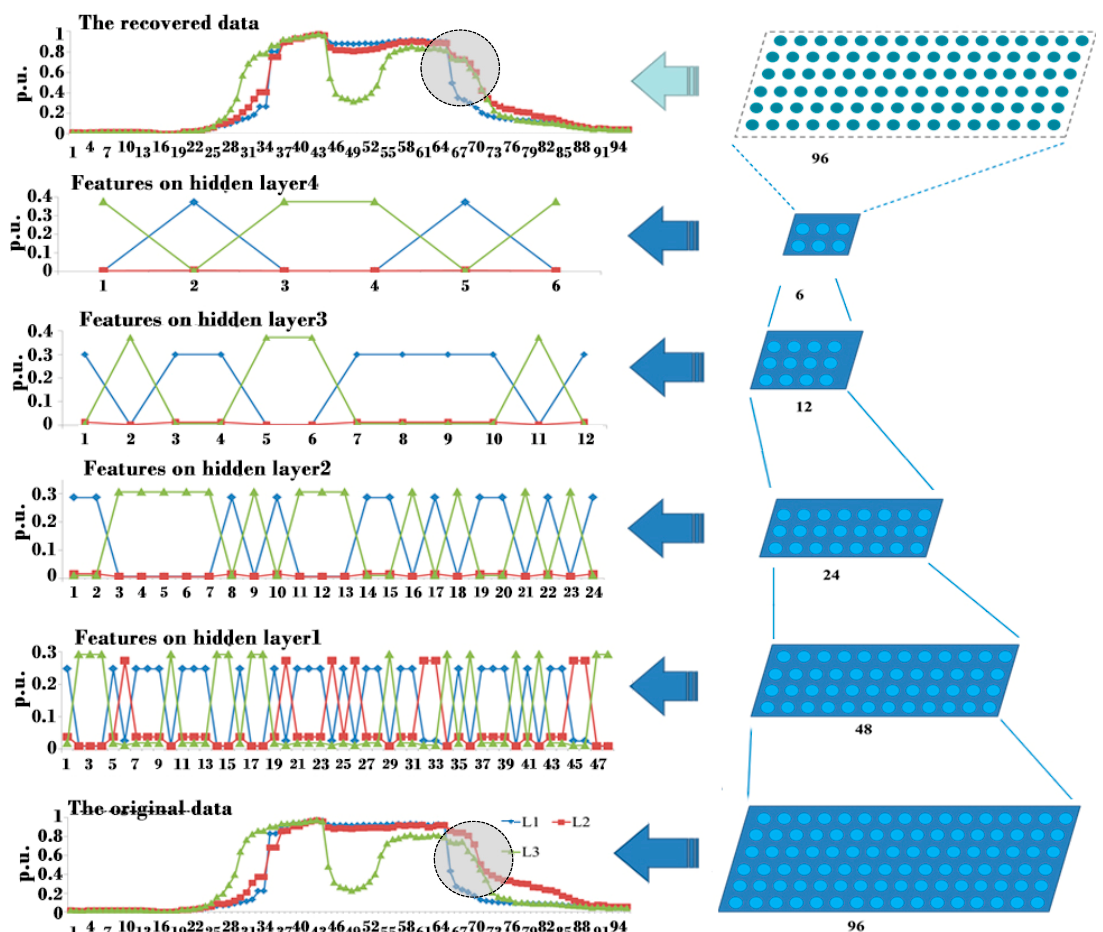
Figure 8. Features extracted on different hidden units of stacked auto-encoder (SAE) (96/48/24/12,500).